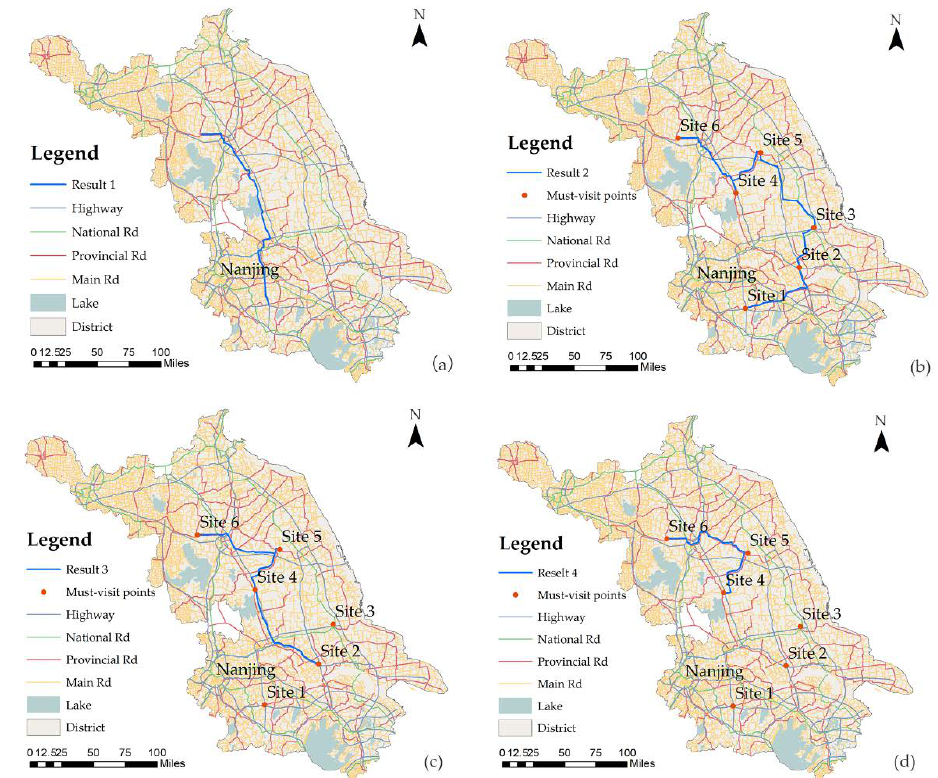
Figure 6. Demonstration of optimal path searching with dynamic addition of different constraints. ( a ) the shortest path without any constraints; ( b ) the winding path with the dynamically added node constraint; ( c ) the updated path when one of the constraint nodes was omitted; ( d ) the affordable path when the attribute-related constraint of the highway road was incorporated.